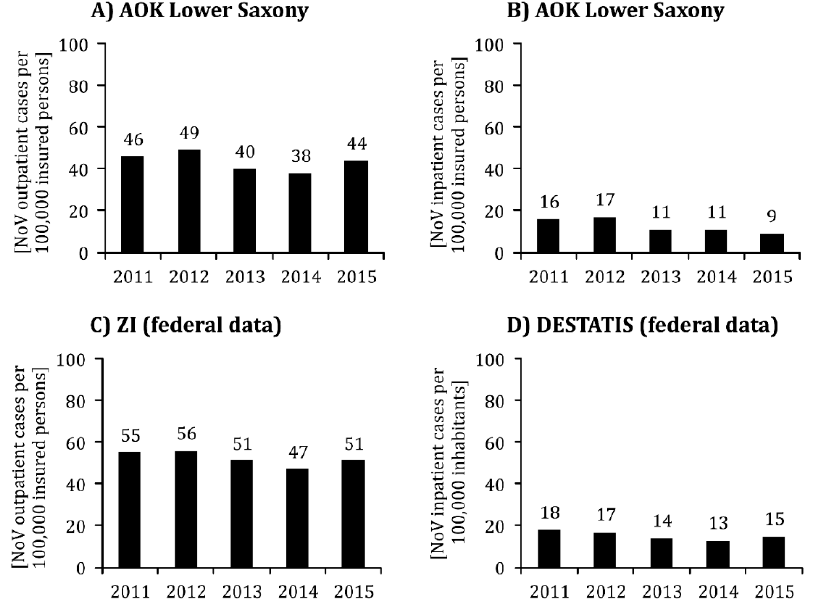
Figure 1. Incidence (cases per 100,000 insured persons or inhabitants) of the ICD10 diagnosis A08.1 ‘Acute gastroenteritis caused by Norovirus (Norwalk virus)’ from 2011 to 2015. Legend: ( A ) only outpatient cases among 18–65 year old insured persons of the statutory health insurance ( Allgemeine Ortskrankenkasse ; AOK) in Lower Saxony; ( B ) only inpatient cases such as A); ( C ) only inpatient cases according to data of the Central Institute for Statutory Health Insurance Physician Care ( Zentralinstitut für die Kassenärztliche Versorgung ; ZI); ( D ) only inpatient cases in 20–64-year-old hospital patients in Germany as a whole (only main diagnosis) according to data from the German Federal Statistical Office (DESTATIS).